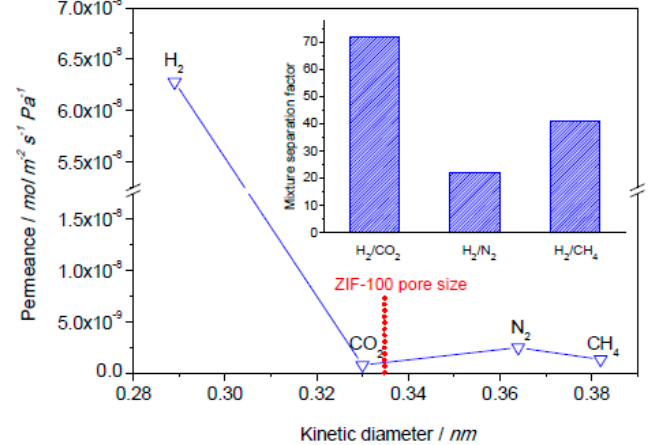
Figure 25. Single gas permeances through the ZIF-100 membrane prepared by PDA-modification at 25 °C and 1 bar as a function of the kinetic diameter of permeated gases. The inset shows the mixture separation factors for H 2 over other gases from equimolar mixtures. (adapted with permission from ref. [126]).